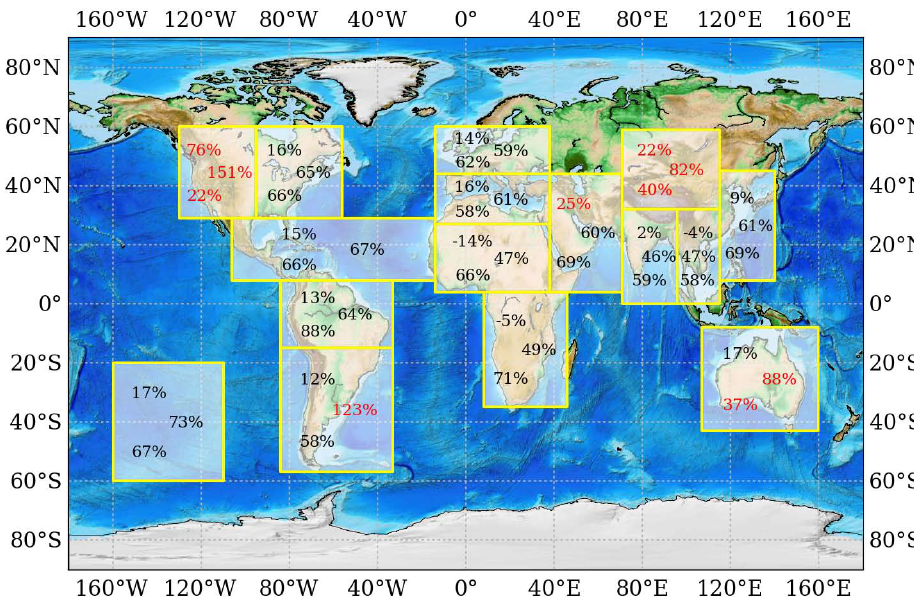
Fig. 4. MBE (top), RMSE (middle) and squared Pearson correlation coefficient R 2 (bottom) for each individual region over the entire study period. The entire dataset scores are shown in the square domain over the South Pacific